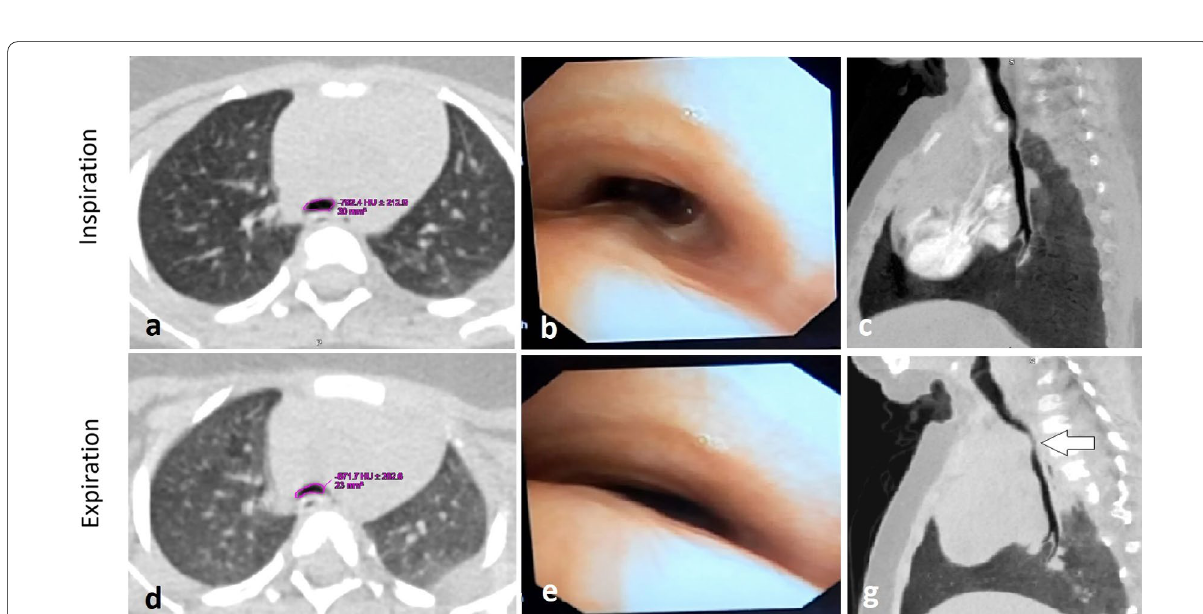
Fig. 3 Expiratory central airway collapse at aortic arch level. Cross-sectional area measurement of trachea at aortic arch level using cine CT during end-inspiratory ( a ) and end-expiratory phases ( d ) revealed significant expiratory airway collapse that was calculated to be 60% cross-sectional area reduction. Corresponding flexible bronchoscopy images are shown ( b , e ) confirming the presence of significant expiratory airway collapse with almost the same degree perceived by CT. Sagittal MinIP images ( c , g ) shows the significant expiratory airway collapse at the same level